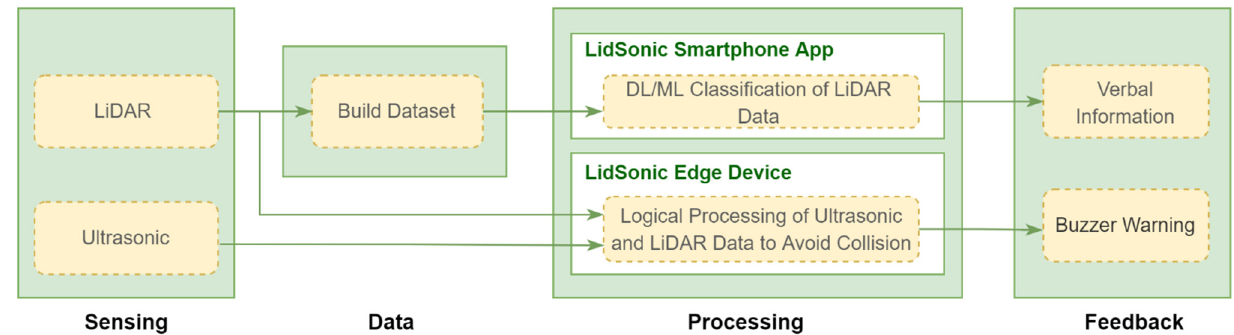
Figure 4. LidSonic V2.0 Overview